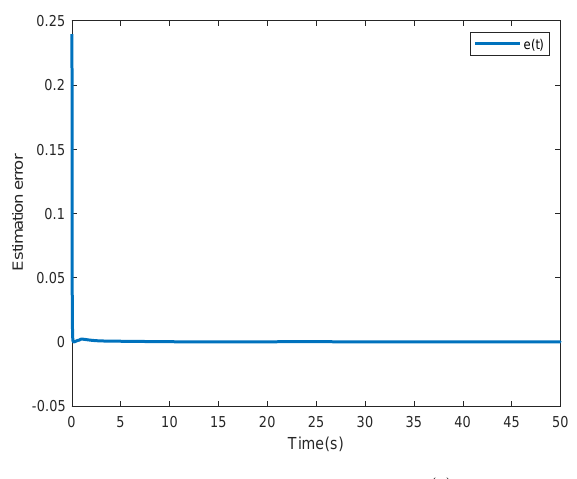
Figure 6. Estimation error e ( t )